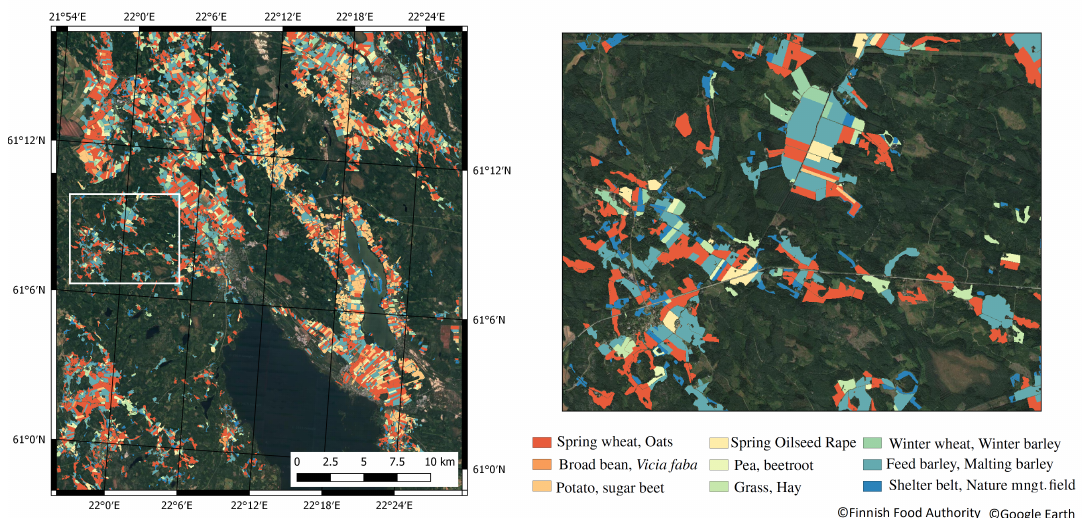
Figure 6. An example of a map of the predicted crop species with the field parcel boundaries, c (cid:13) Finnish Food Authority, c (cid:13) Google